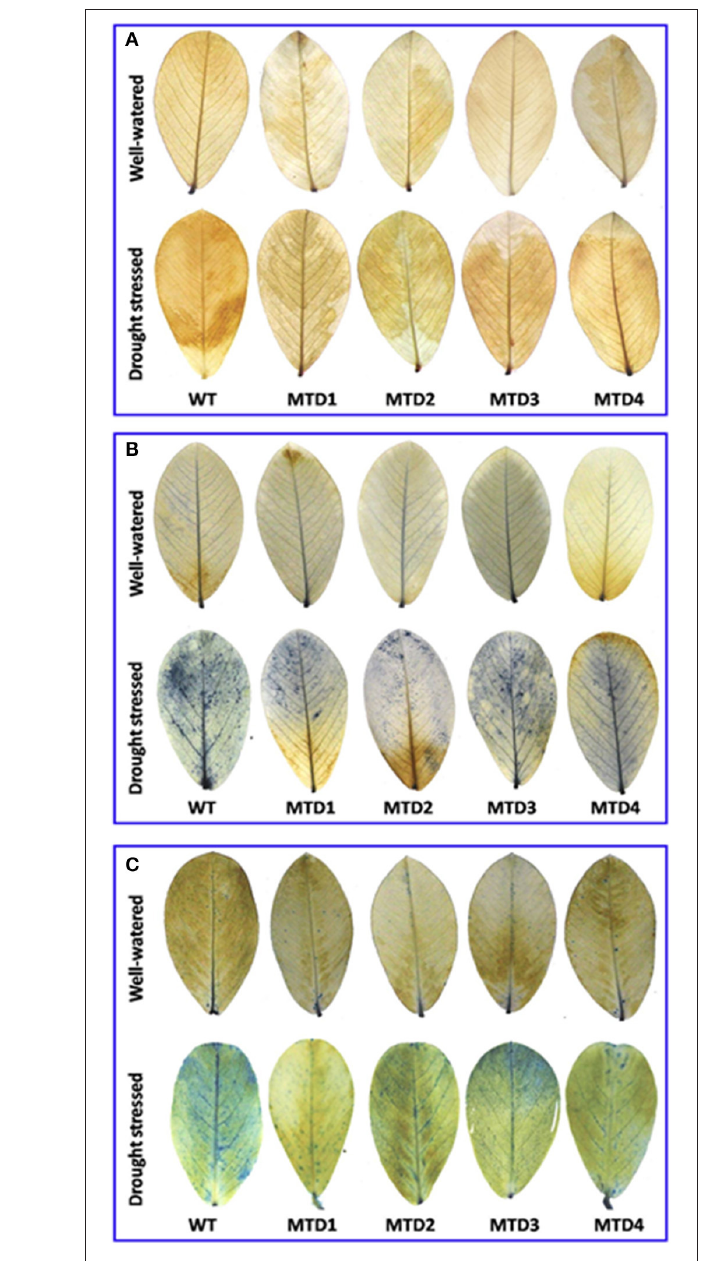
is because of mannitol accumulation, which in turn imparted tolerance to